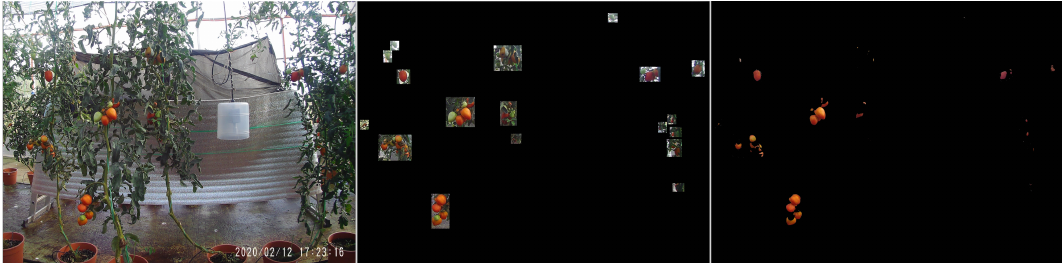
Figure 16. Original image, Convolutional Neural Networks (CNN) pre-processing, and pixel-level processing of sample 38 with 75% diluted nutrient dosage.